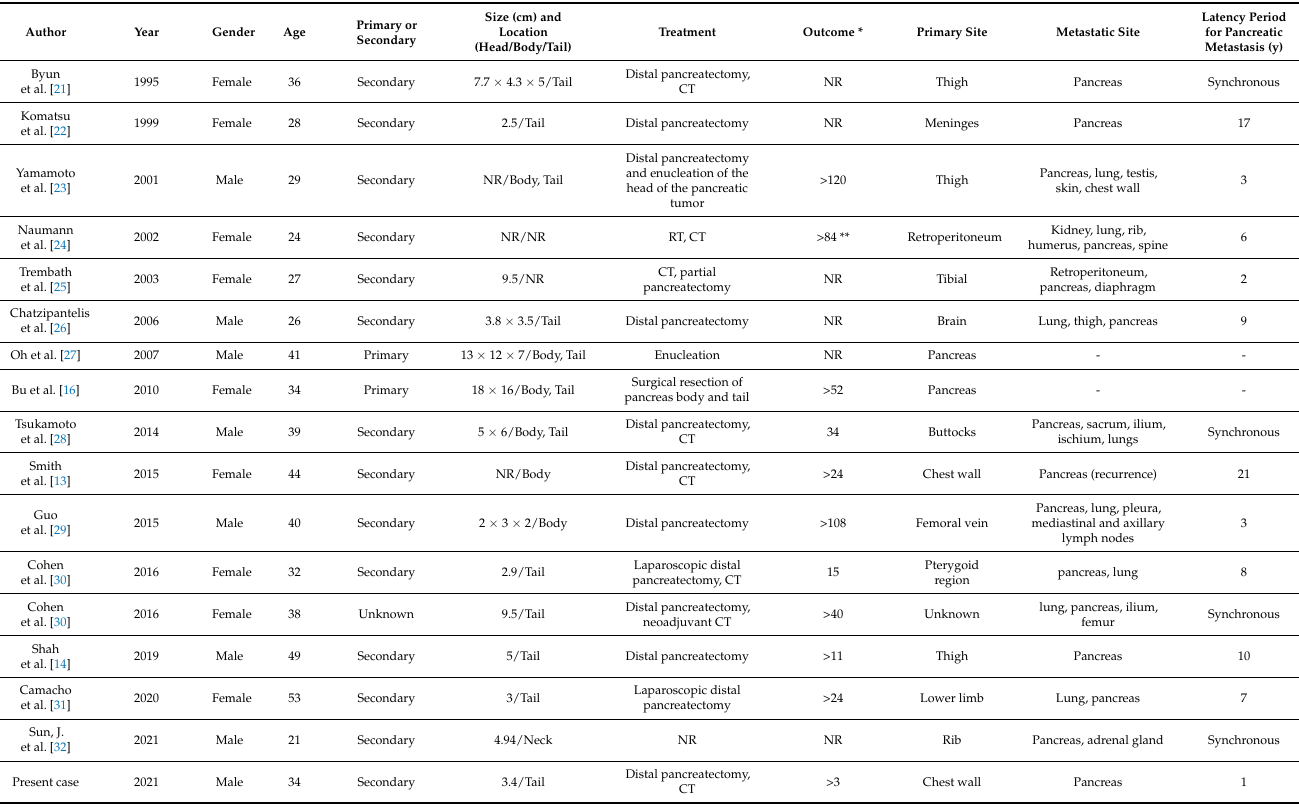
Table 1. Literature review of published case reports with pancreatic